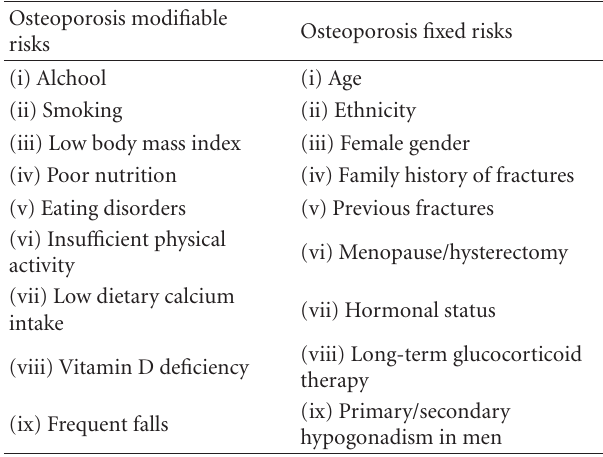
Table 1: Main risk factors for osteoporosis. Osteoporosis